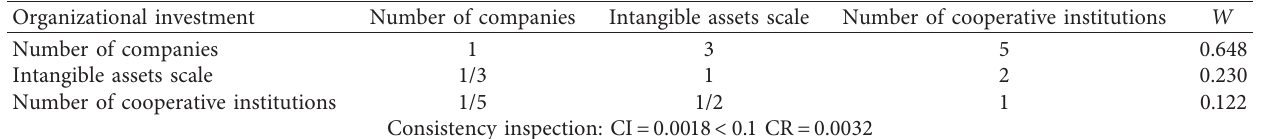
Table 4: Organizational investment judgment matrix.